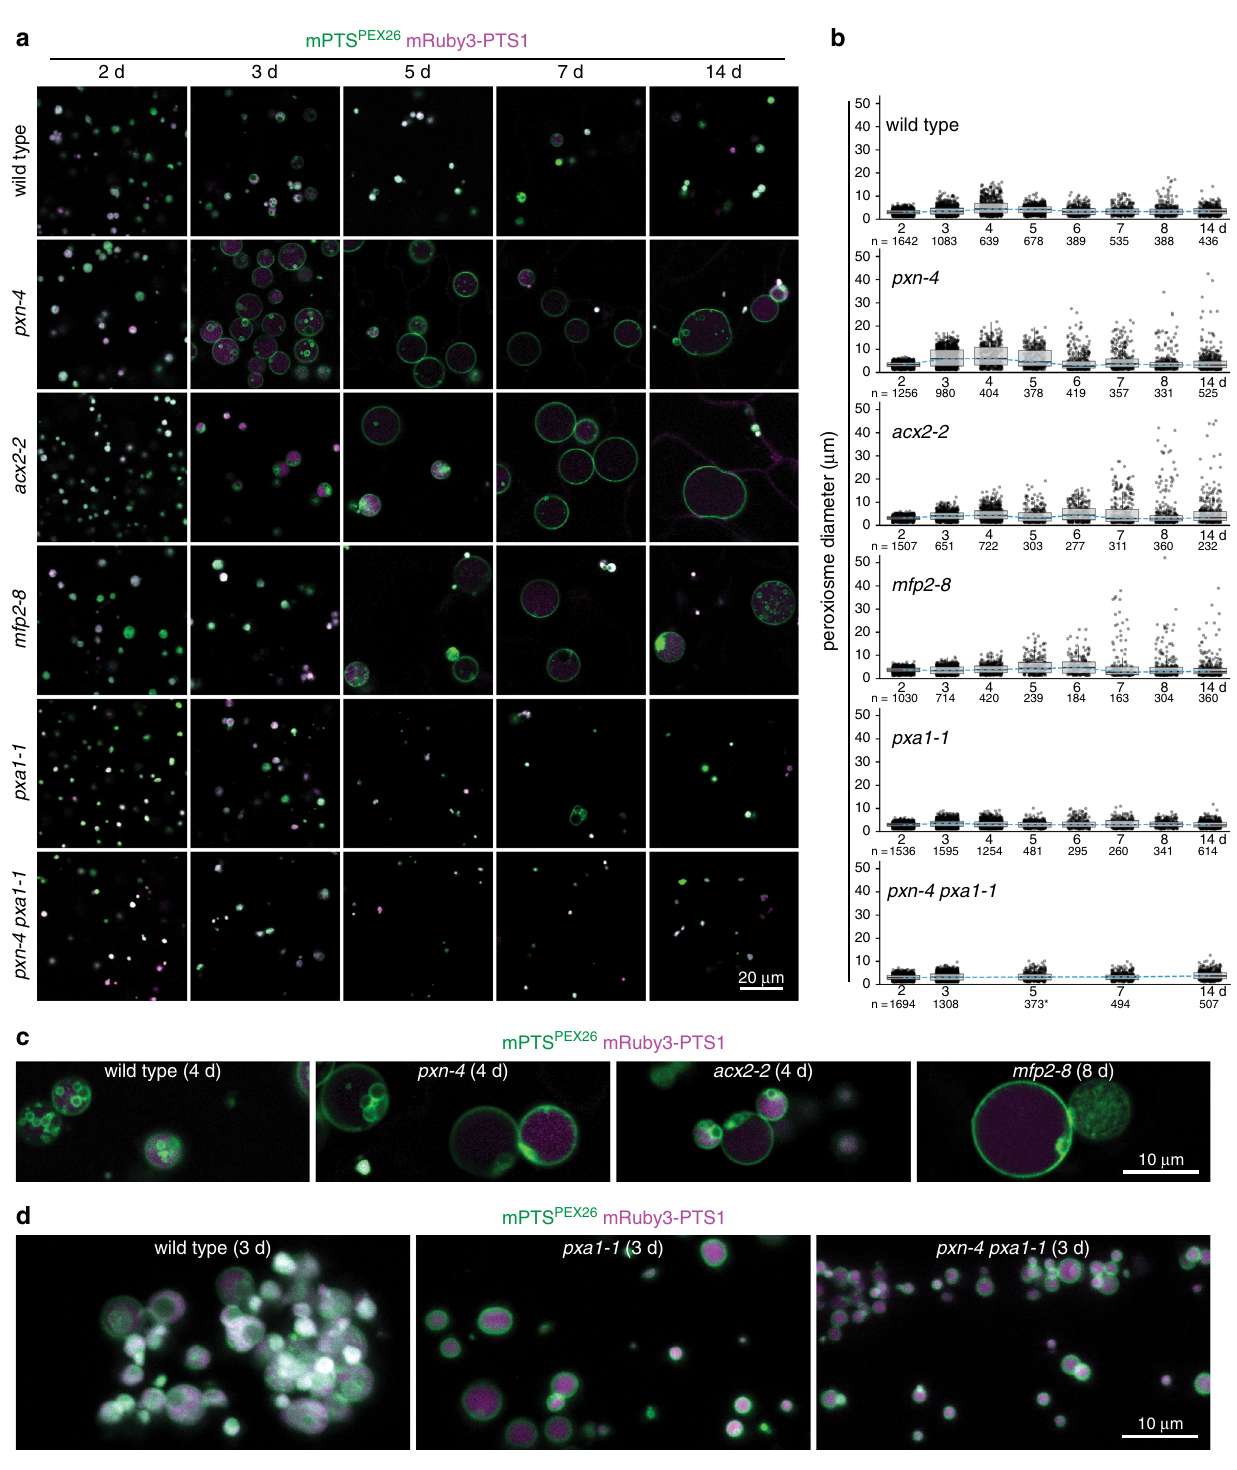
Fig. 4 Ef fi cient peroxisomal ILV formation requires β -oxidation. a , b Enlarged peroxisomes in mutants with impaired β -oxidation show disrupted ILV formation. Wild-type seedlings and various mutants with impaired β -oxidation expressing mNeonGreen-mPTS PEX26 (green) and mRuby3-PTS1 (magenta) were imaged over several days; cross-sections ( a ) and peroxisome diameters ( b ) are shown. Boxes show second and third quartiles, horizontal lines are medians, and whiskers encompass data points up to 1.5 times the interquartile range past the box ends. c Magni fi ed peroxisome cross-sections show ILVs in wild-type peroxisomes dispersed in the lumen and residual ILVs in pxn-4 , acx2-2 , and mfp2-8 aggregated near the outer membrane. d Z -projections of peroxisomes in root cells show wild-type peroxisomes with densely packed inner membranes and pxa1-1 and pxn-4 pxa1-1 peroxisomes lacking most inner